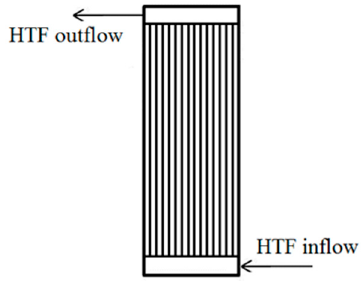
Figure 5. Schematic of the cold storage tank with PCM.